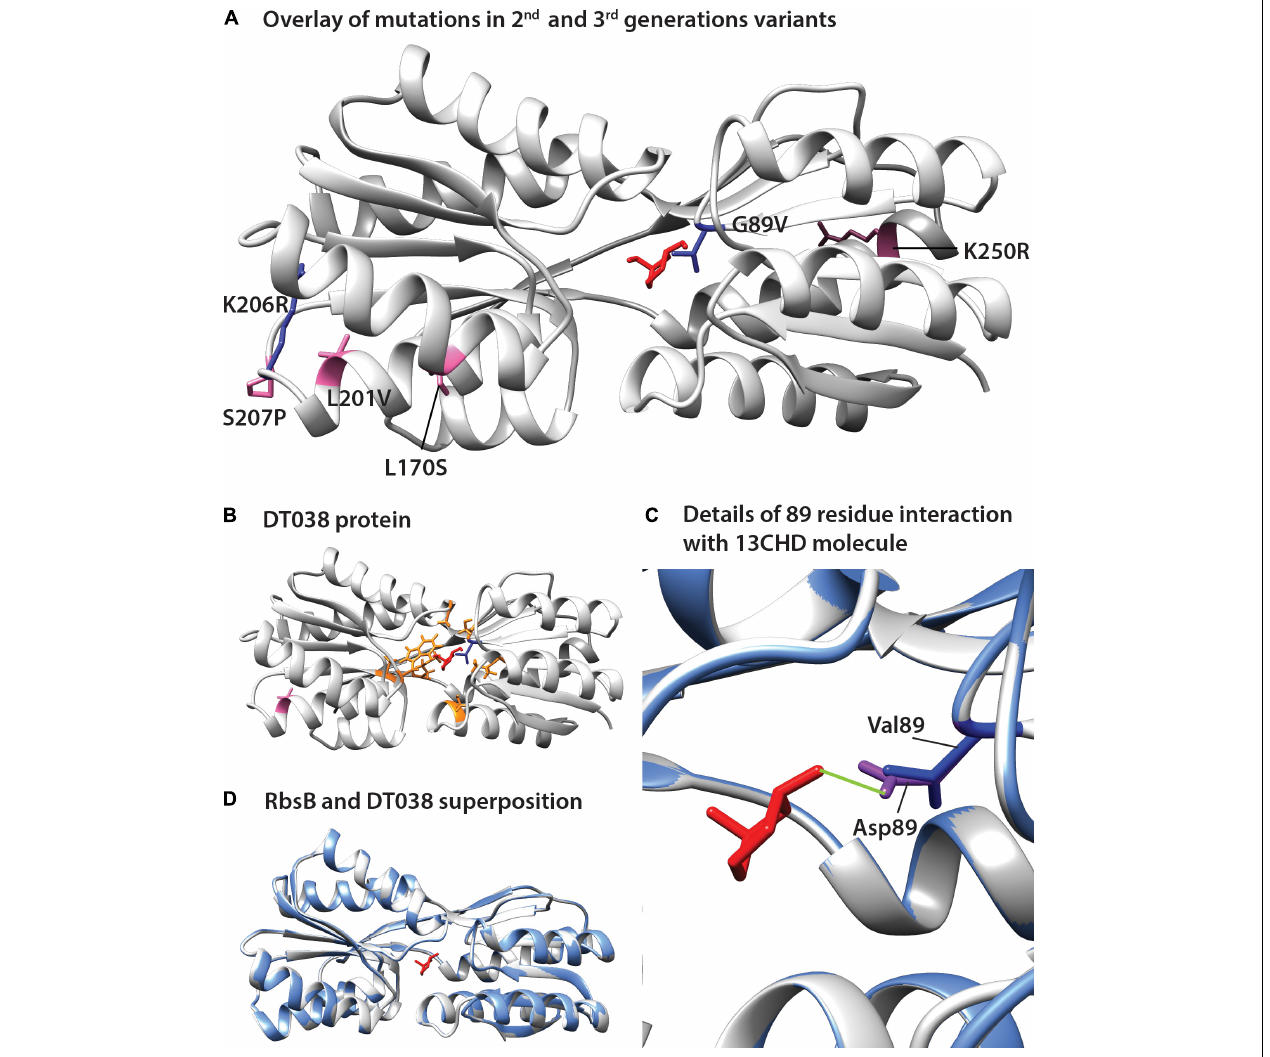
FIGURE 3 | Positions of amino acid substitutions observed in various 13CHD mutants, visualized on the closed structure of wild-type RbsB (PDB ID: 2DRI). (A) Mutated residues in 2nd (blue) and 3rd generation mutants (pink). (B) Acquired mutations in DT038, seen as a superposition of 1st (orange, in DT016; the original Rosetta designed binding pocket mutations), 2nd (blue, in DT022) and 3rd generation mutations (pink). (C) Superposition of wild-type RbsB (PBD ID: 2DRI, blue), and the threaded DT038 structure (light gray). (D) Detailed view from (C) panel, showing the interaction between ligand and residues located at 89 position. Asp89 of RbsB and Val89 of DT038 are colored in purple and blue, respectively. Light green line indicates a H-bond. Molecular structures of 13CHD (red) are placed in the binding pocket. Signal peptide mutations are not shown on the structure as this is cleaved